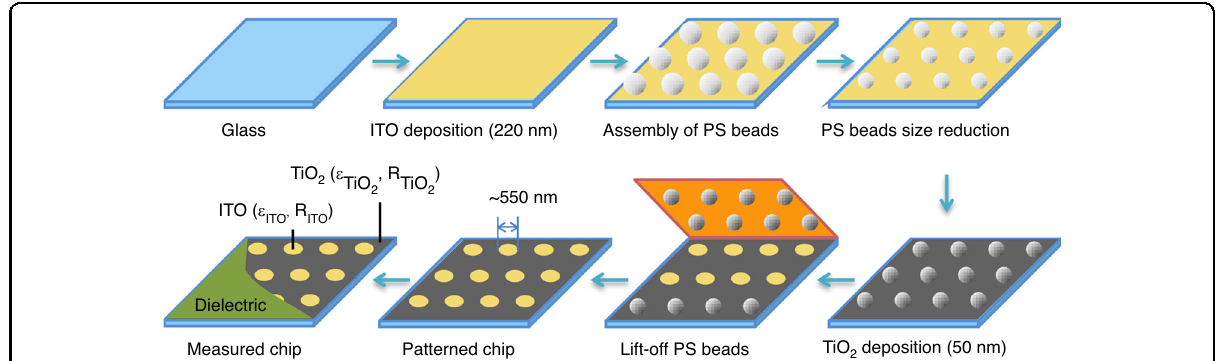
Fig. 2 Schematic representation of the nanopatterned calibration chip fabrication steps. The different electrical (relative permittivity, ε i ) and optical (re fl ectance, R i ) properties of the two materials, i = TiO 2 and ITO, tailor the optical and electrical contrast of the chip that is included in an electrochemical cell using a dielectric fl ow cell boundary